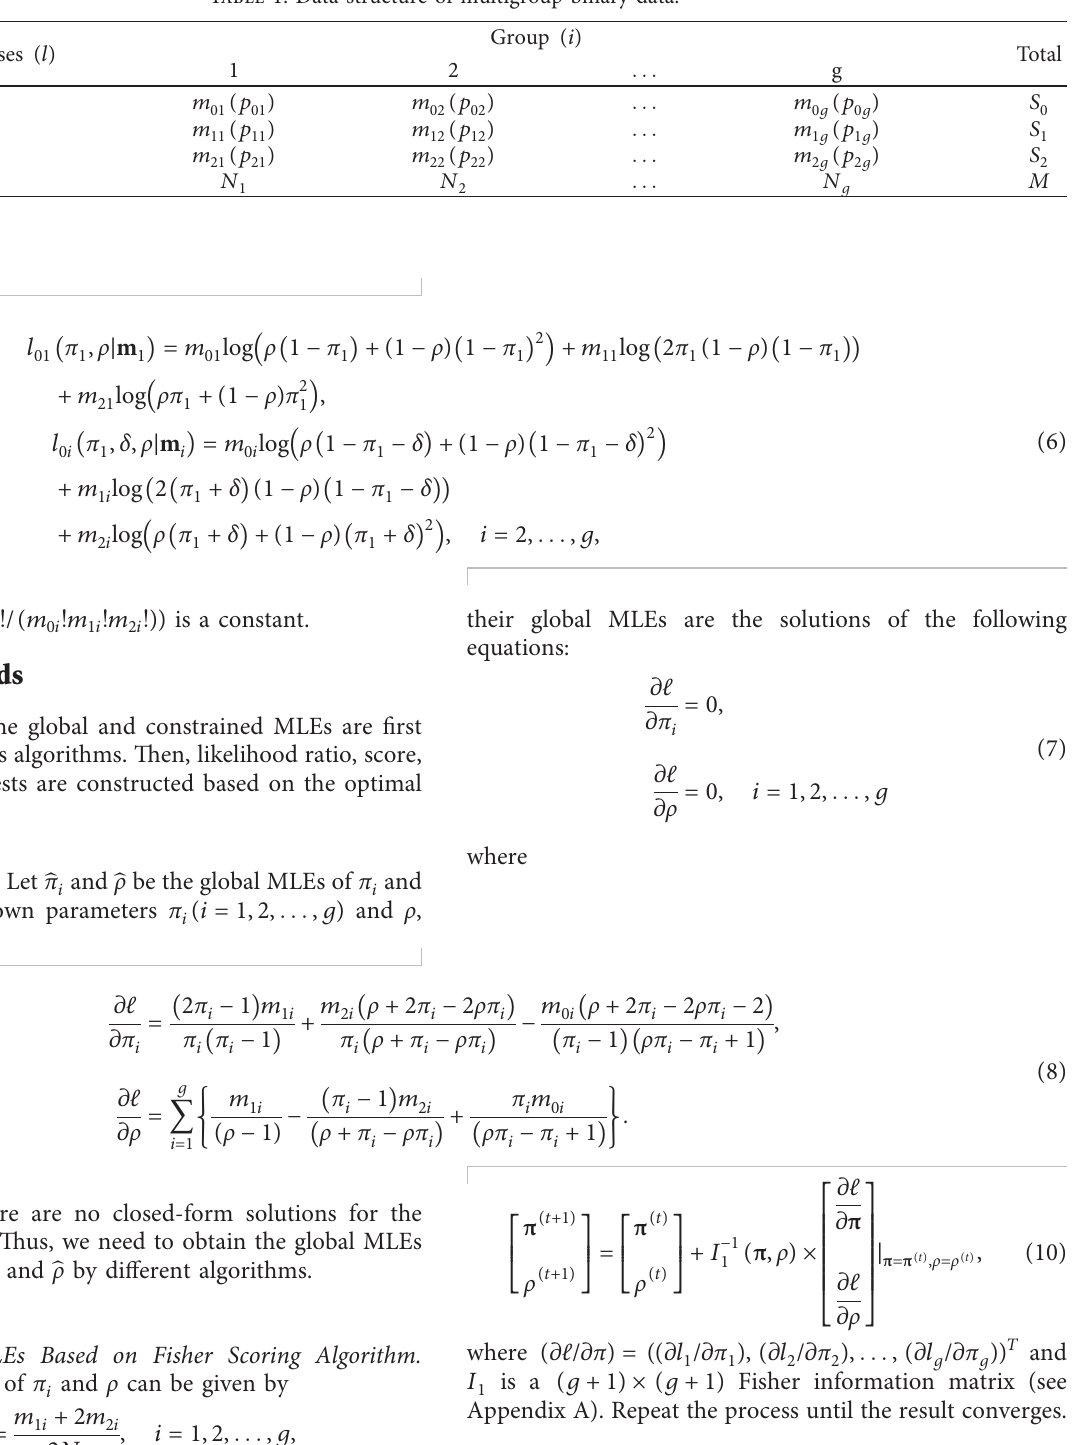
Table 1: Data structure of multigroup binary